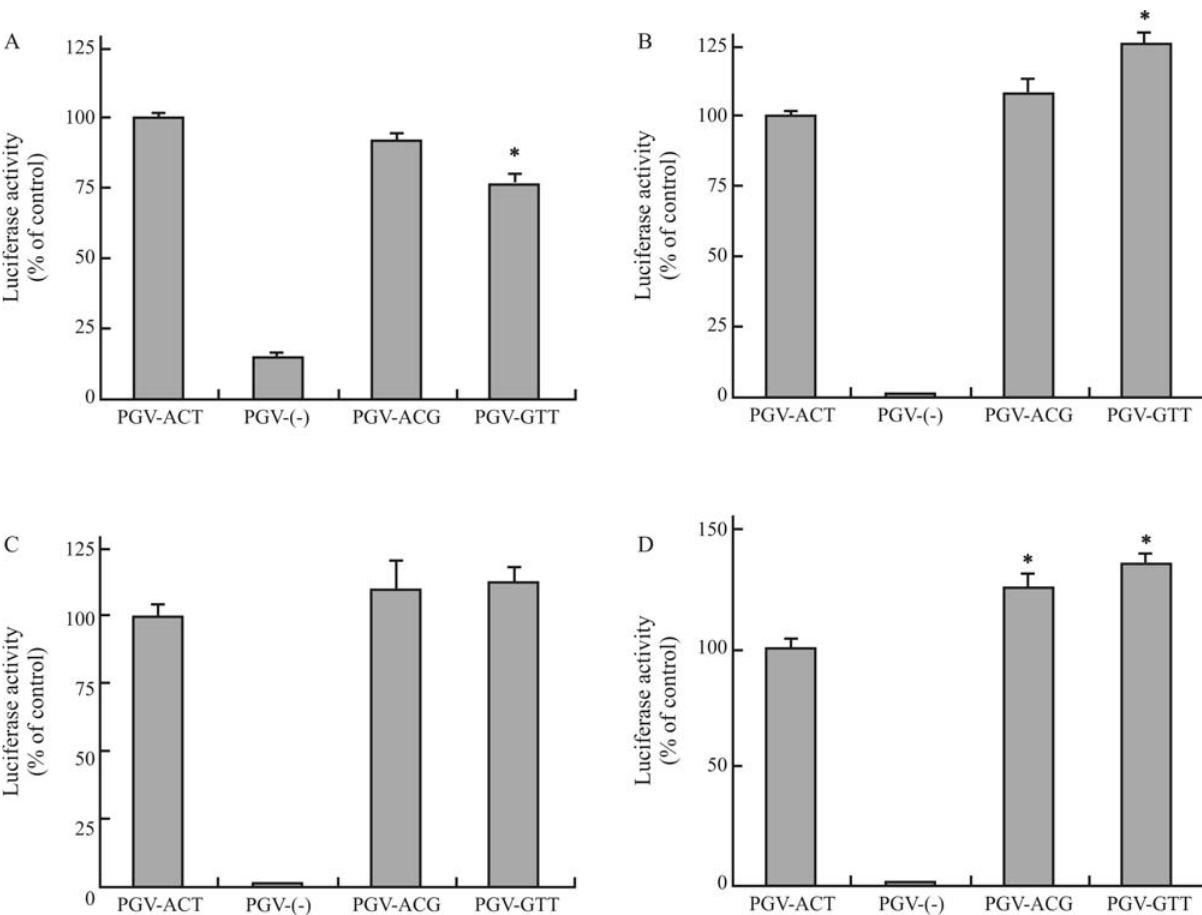
Figure 5 - Effects of MDM2 polymorphisms on luciferase activity in different cell lines. (A-D) Colo320DM (A), U251 (B), T98G (C), and YMB-1 (D) cells were transfected with the indicated vector constructs of PGV-(-), PGV-ACT, PGV-ACG, and PGV-GTT. The transfected cells were cultured for 24 h, and luciferase activity was determined. Data are shown as percentages of values obtained from the PGV-ACT transfectants and are expressed as the mean (cid:5) SEM (n = 8) (A-D). *: Significant difference compared with the PGV-ACT